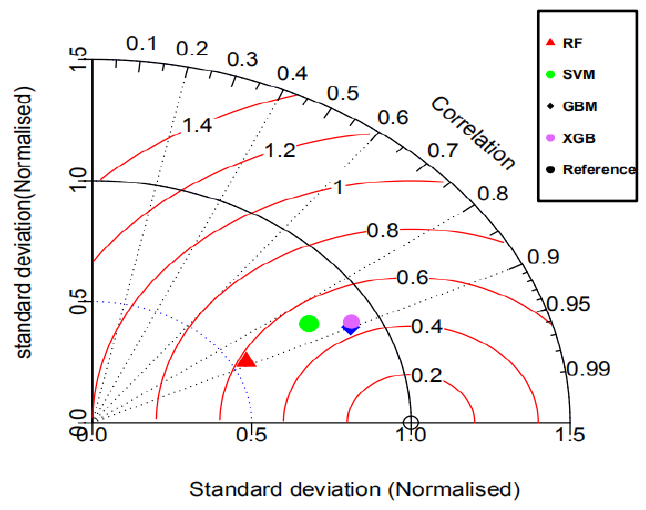
Figure 14. Taylor’s plot for ML model testing datasets.